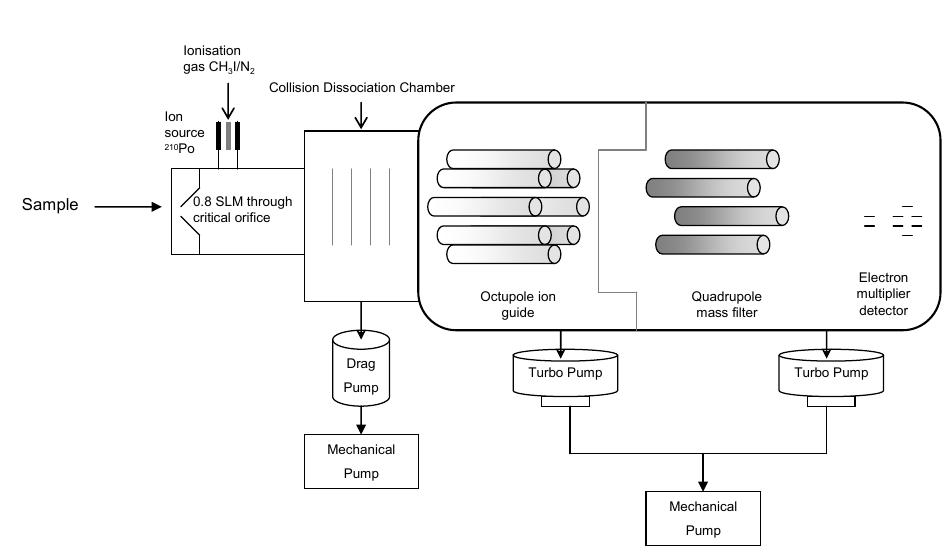
Figure 1 : A schematic diagram of the EXTRA chamber